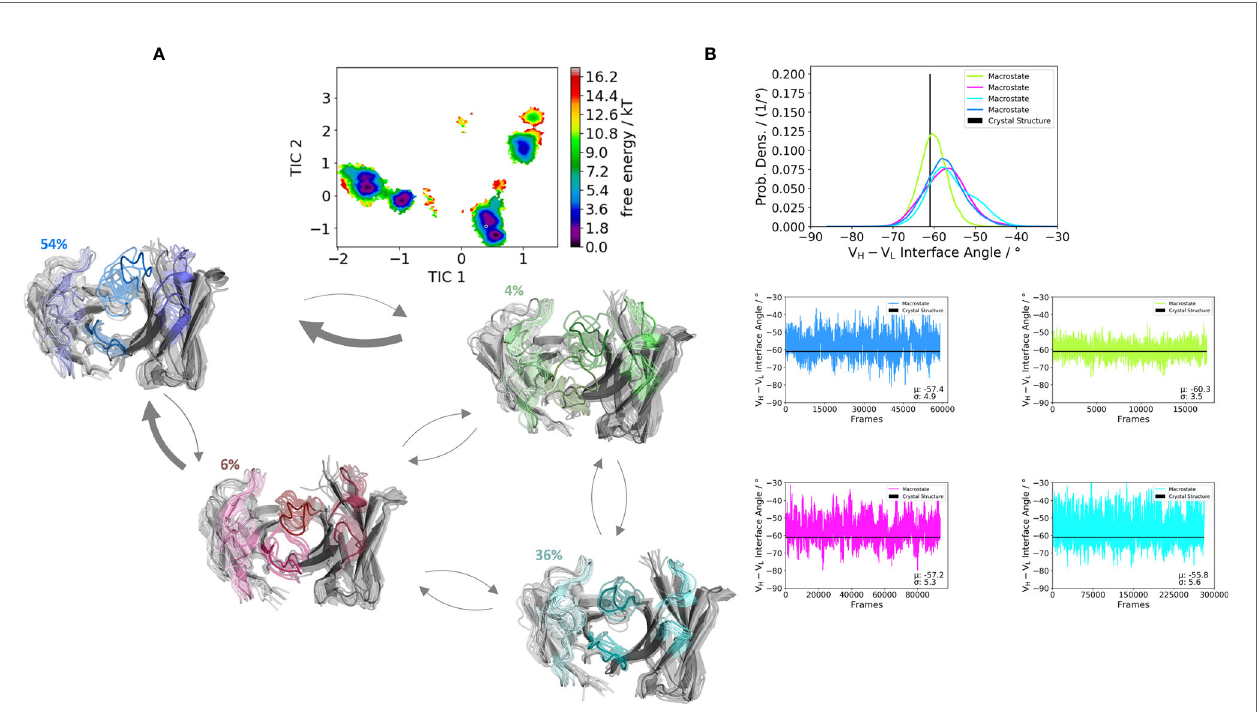
FIGURE 6 | Germline pairing speci fi c paratope states in solution for the H3-53:L4-1 (5I1I) Fab. (A) Illustrates the paratope states, free energy surface, macrostate ensemble and the respective V H and V L orientations for the 5I1I antibody. (B) Also, here we fi nd small shifts in the V H and V L orientations upon rearrangements in the paratope. Especially interesting is the fact that different germline pairings favor speci fi c interdomain orientations. The highest variations in these interdomain angle distributions can be observed for the 5I1I, which is also one of the least stable Fab fragments. The starting X-ray structure for the underlying simulations is depicted as black dot in the free energy surfaces and as black line in the plots showing the V H -V L angle distributions.